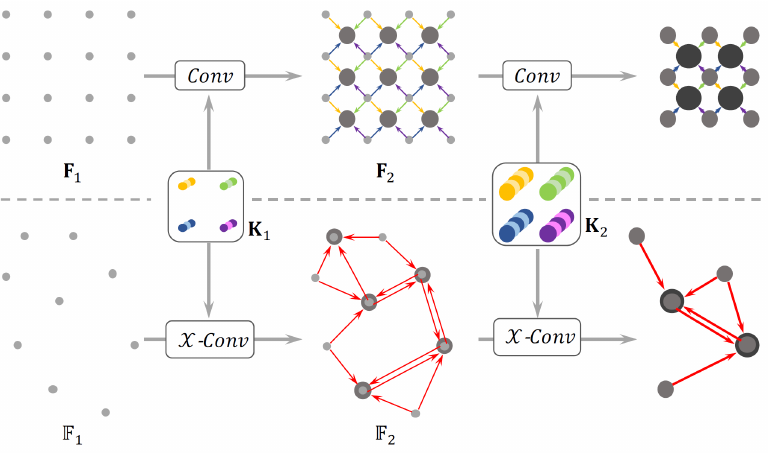
Figure 9. PointCNN [76] χ -Conv operator.